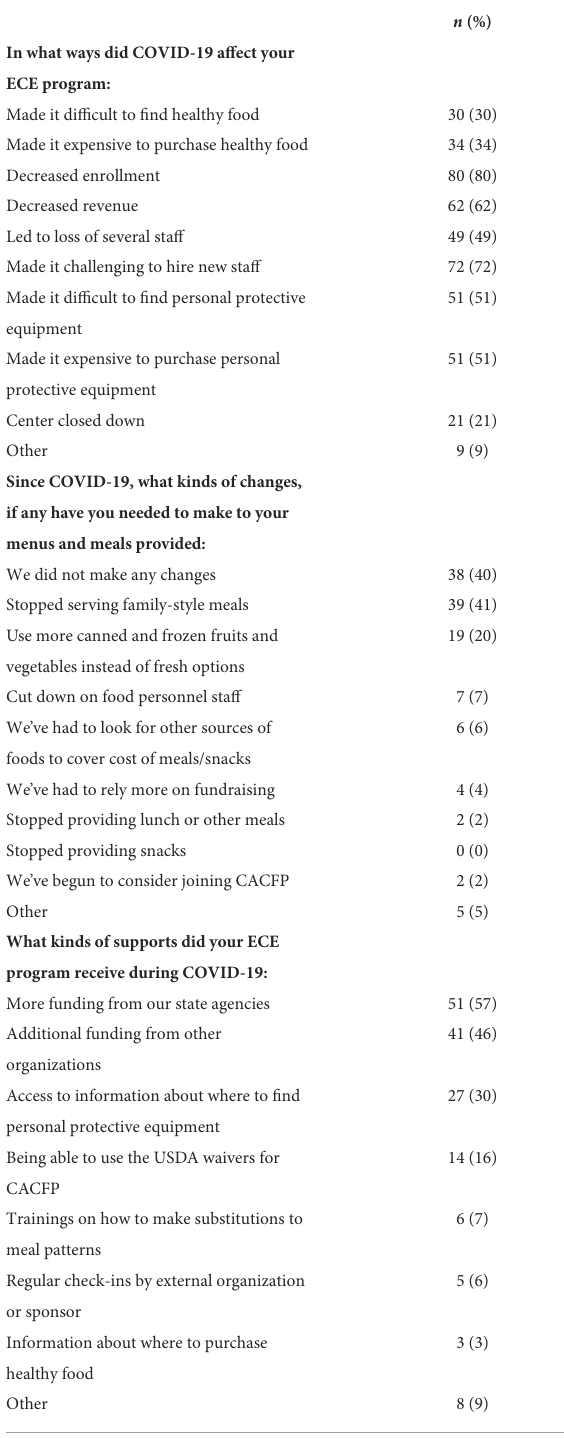
TABLE 2 Demographic characteristics of center-based early care and TABLE 3 COVID-19 experiences reported by center-based early care education (ECE) programs from directors that completed a survey a . and education (ECE) program directors that completed a survey a n = 100 ECE programs